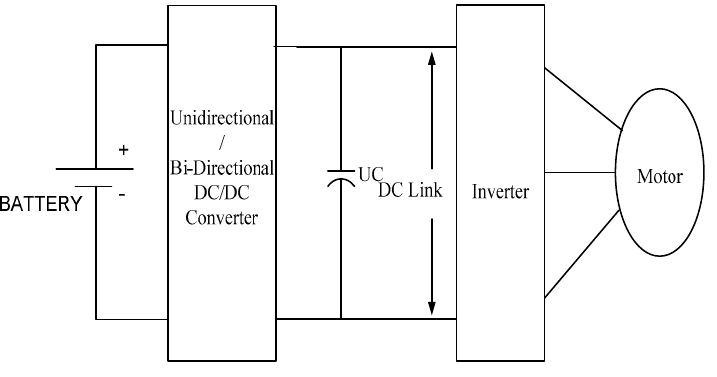
Figure 4. Battery/UC design.